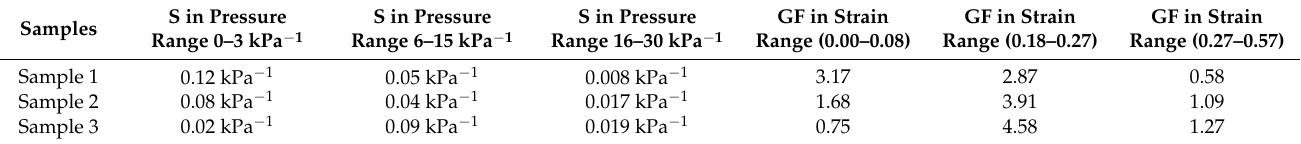
Table 2. Sensitivity (S) and gauge factor (GF) of all samples in different pressure